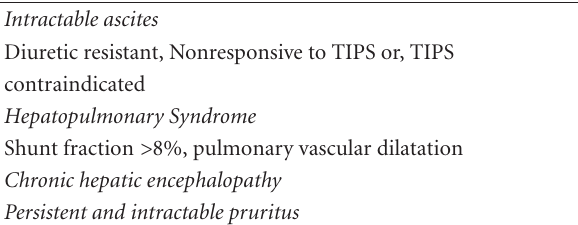
Table 2: Indications for liver transplantation. Table 3: Variant syndromes requiring liver